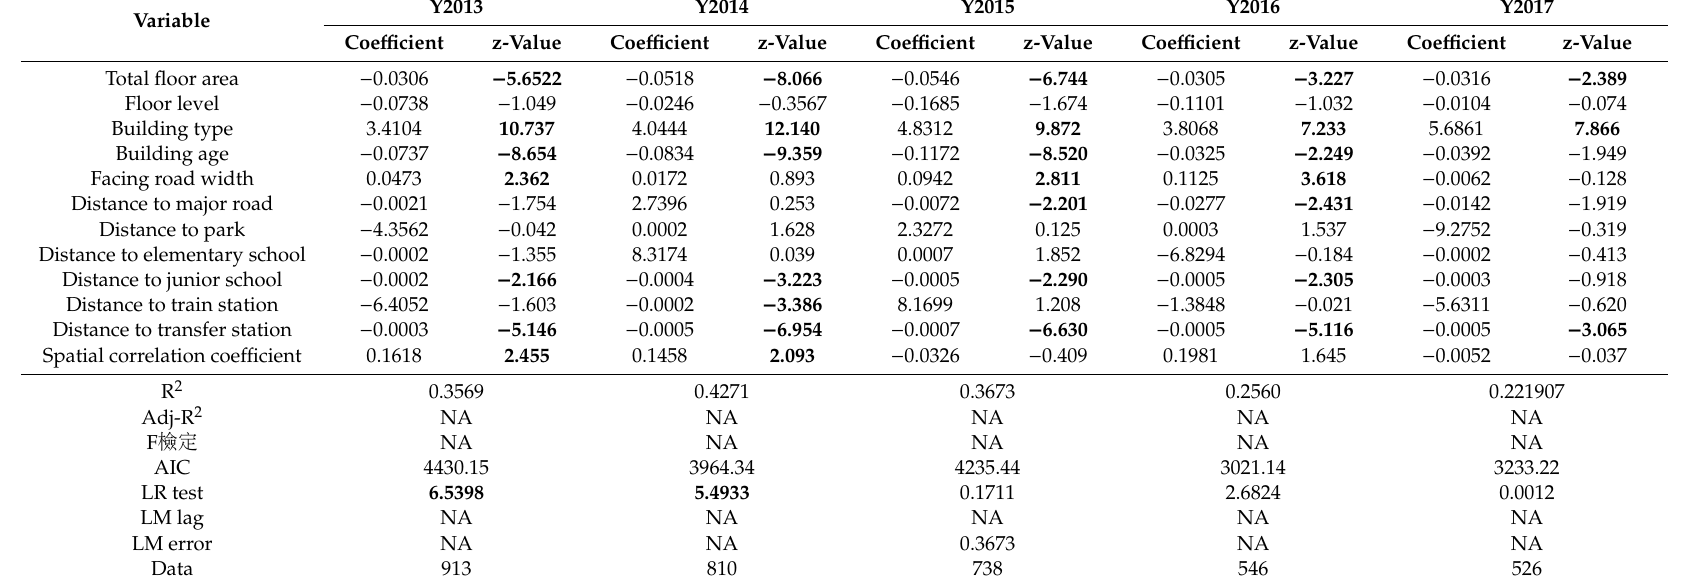
Table 3. The analysis results between 2013 and 2017 by the spatial lag model